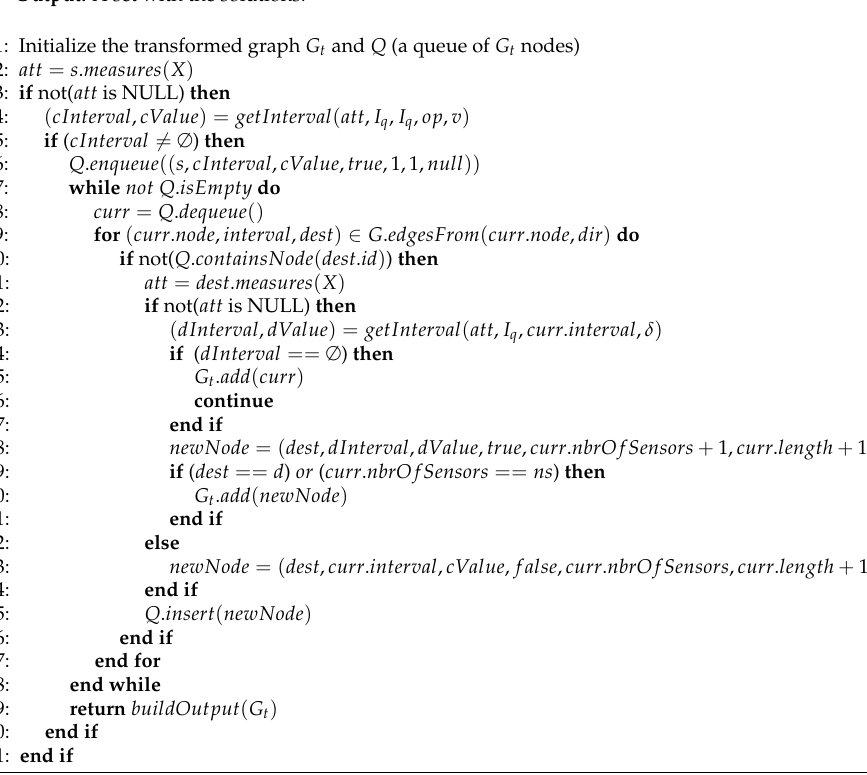
Algorithm 1 builds a transformed graph G t , whose nodes contain either the inter- val when the value of X op v was valid (if they are sensor nodes) or the interval of the